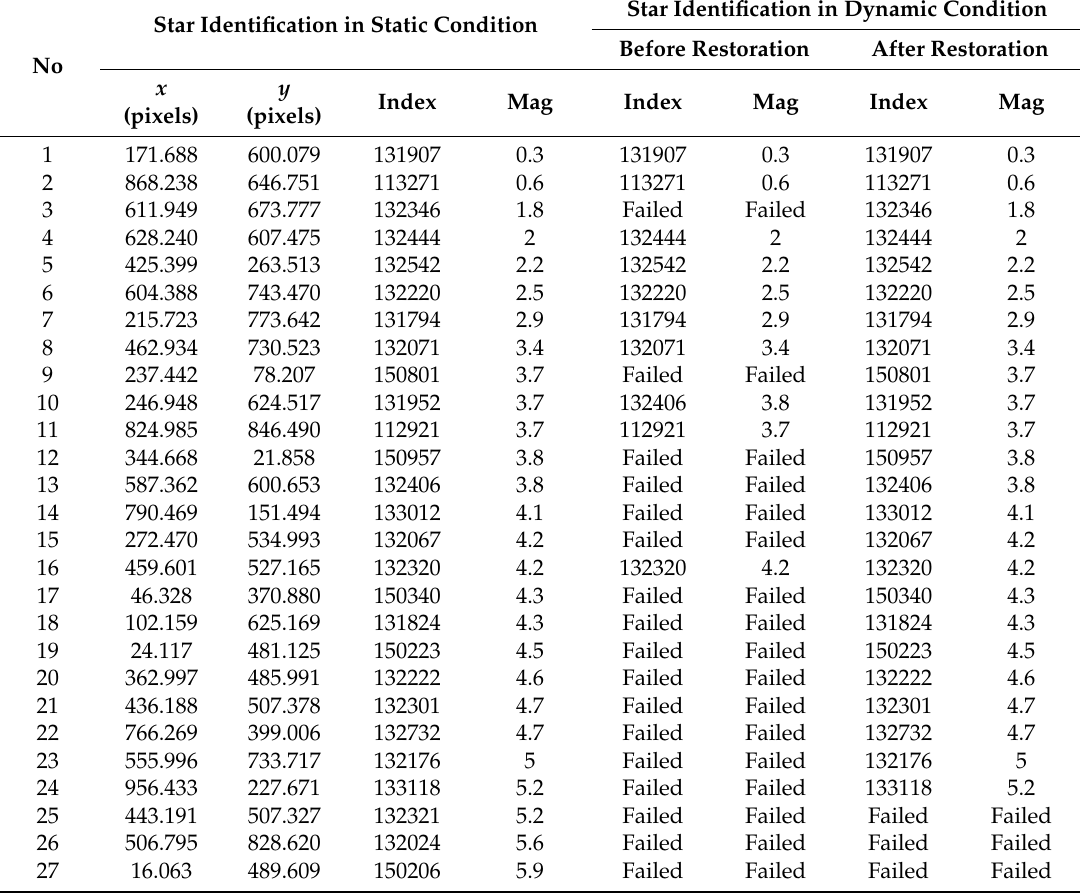
Table 5. Star identification before and after